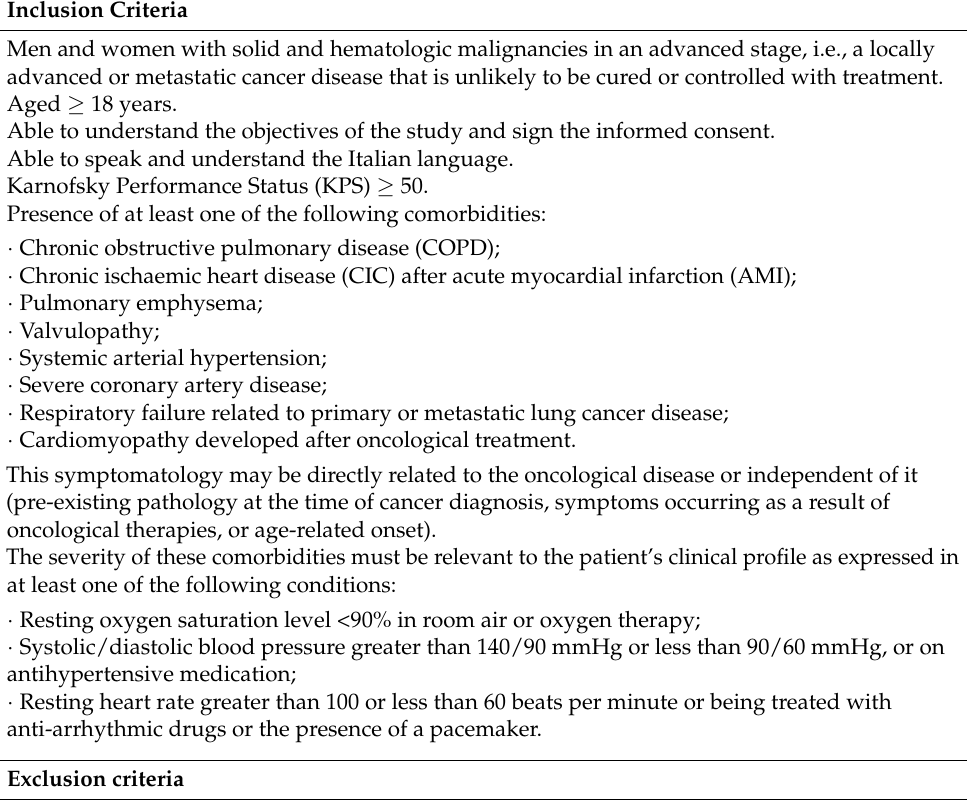
Table 1. Inclusion and exclusion criteria for eligible participants. Inclusion